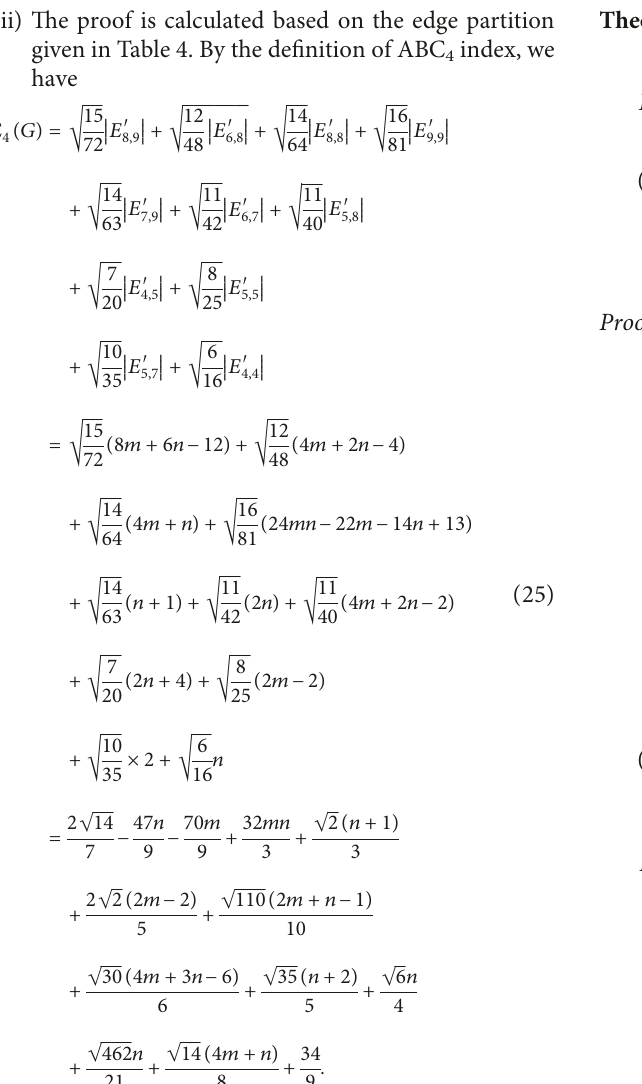
E s,t (b) and HC 5 C 7 (2, 4) by different